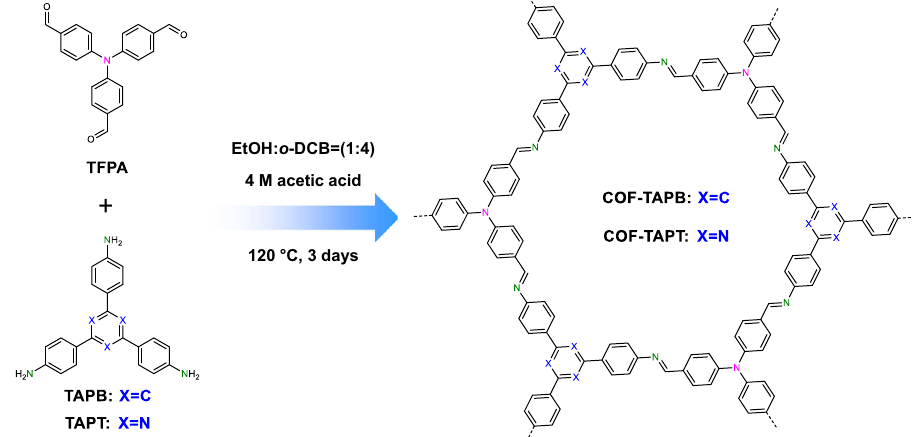
Fig. 1 Schematic illustration of the synthesis of COF-TAPT and COF-TAPB. In the structural model, different N sites are marked with different